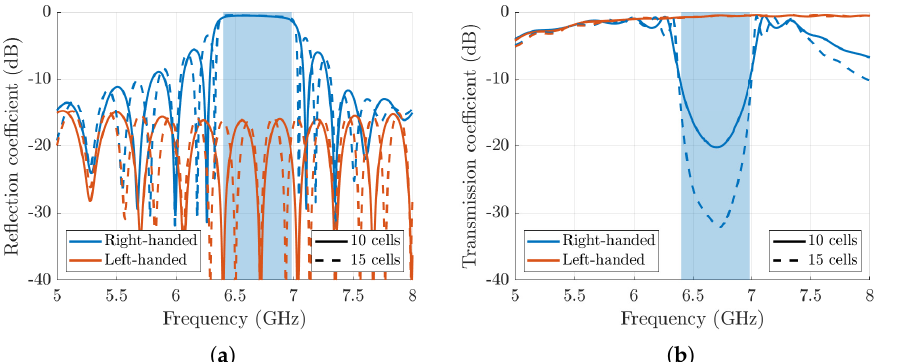
Figure 6. Circular S-parameters of a truncated structure with 10 and 15 unit cells of a twist-symmetric dielectric rod with parameters: p = 15.4mm, w = p /4, r 1 = 7mm, r 2 = 4.2mm, (cid:101) 1 = 10 and (cid:101) 2 = 3. ( a ) Reflection coefficient. ( b ) Transmission coefficient. The shaded region indicates the bandgap calculated using the eigenmode